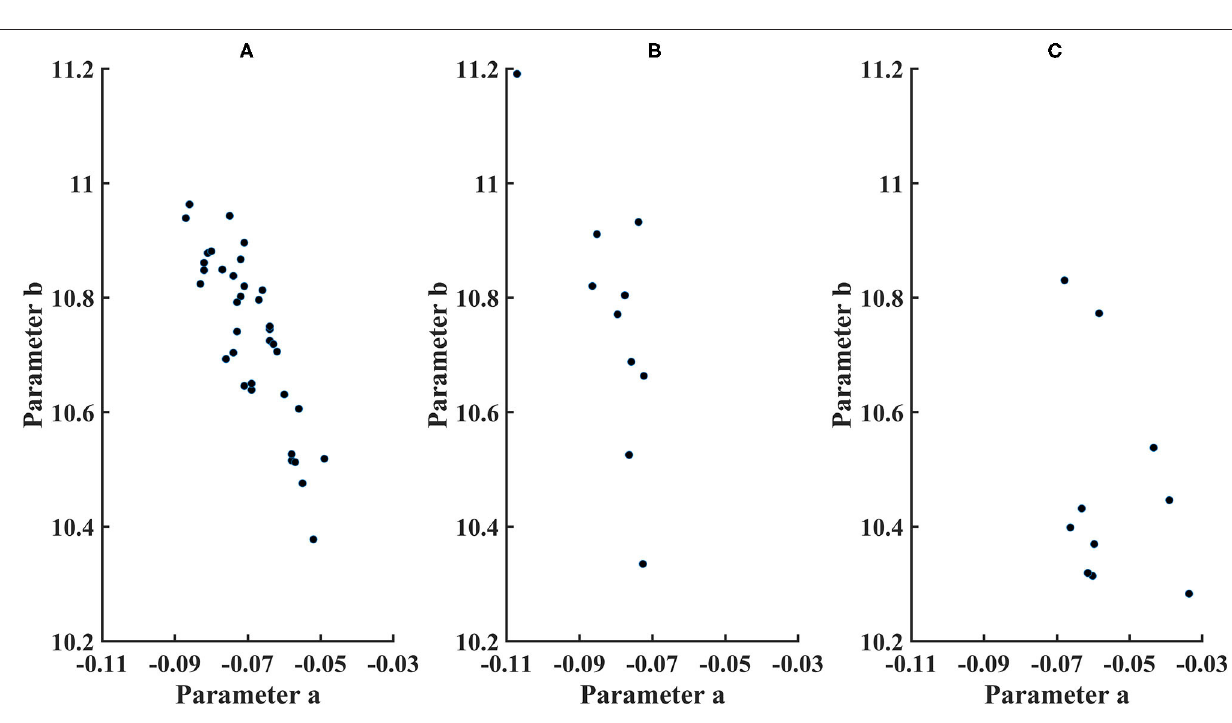
respectively, [F (35,9) = 4.03, p < 0.025]. This finding is based on, and consistent with, the high intra-individual variability of cone density reported previously in the younger subjects based on 10